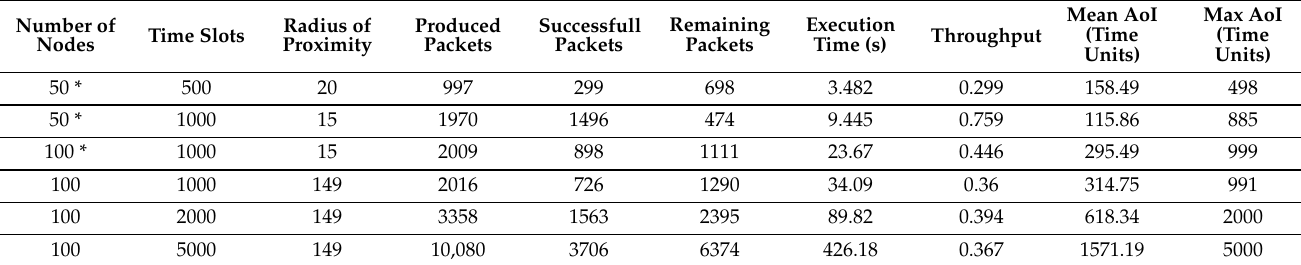
Table 7. Initial results for FRESH-near-v2.